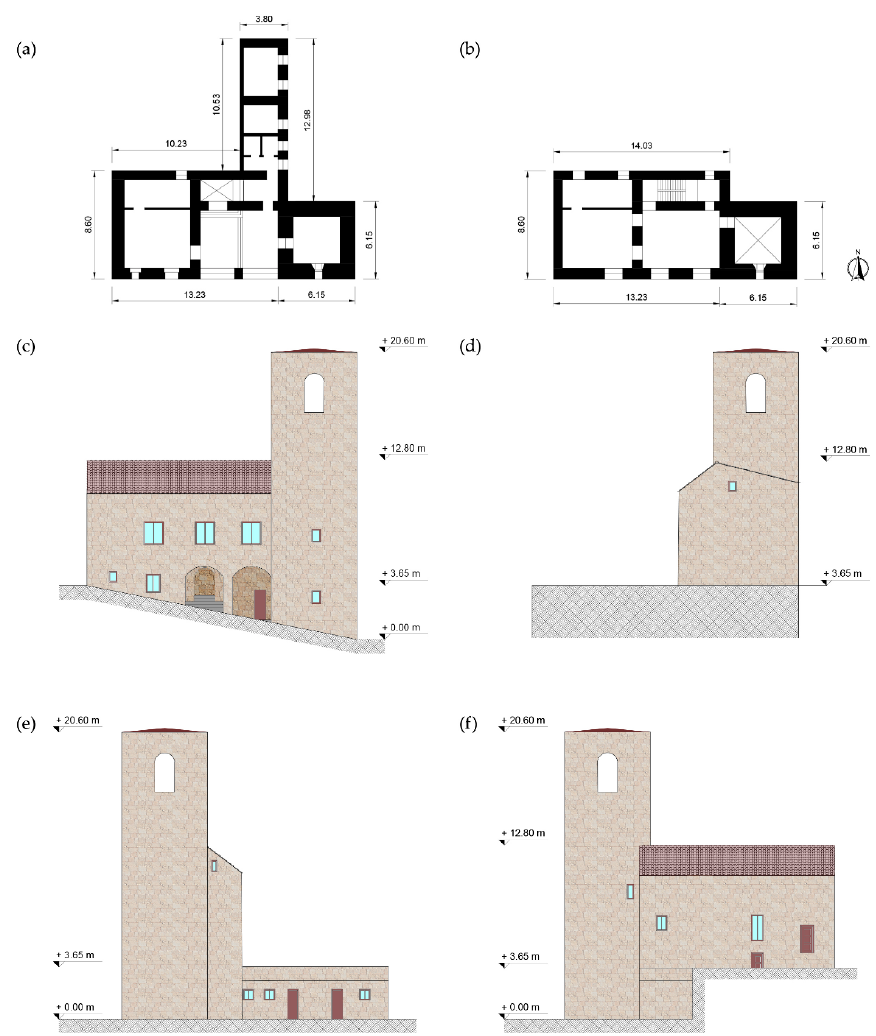
Figure 2. Ground ( a ) and first ( b ) floor layouts, and the south ( c ), west ( d ), east ( e ), and north ( f ) façades, respectively. (All the dimensions are expressed in meters.) The tower has a square cross-section of 6.15 m on each side and a maximum height of 20 m. The walls’ thicknesses are almost constant and equal to 1.2 m. It shows four single- arch windows in correspondence with the bell cell and three embrasures along the height. Inside, there is one masonry cross vault, whereas the pitched roof is made with reinforced concrete. Regular cut stones characterize the external tower masonry, and the walls’ thick- ness suggests the presence of an inner core of rubble stone. The two floors of the Podestà Palace have a rectangular cross-section that measures 8.60 × 14.00 m 2 . The maximum building height, estimated at the ridge of the roof, accounts for a value of 12.8 m. On the first floor, there is the entrance, consisting of an arched por- tico. The “Piano Nobile” is located on the first floor. The slabs are made of wood, except for a masonry cross vault on the stairwell. The palace-bearing structure is composed of regular cut stone. On the south side, there is a one-floor annex of 10.50 × 3.80 m 2 in dimensions.